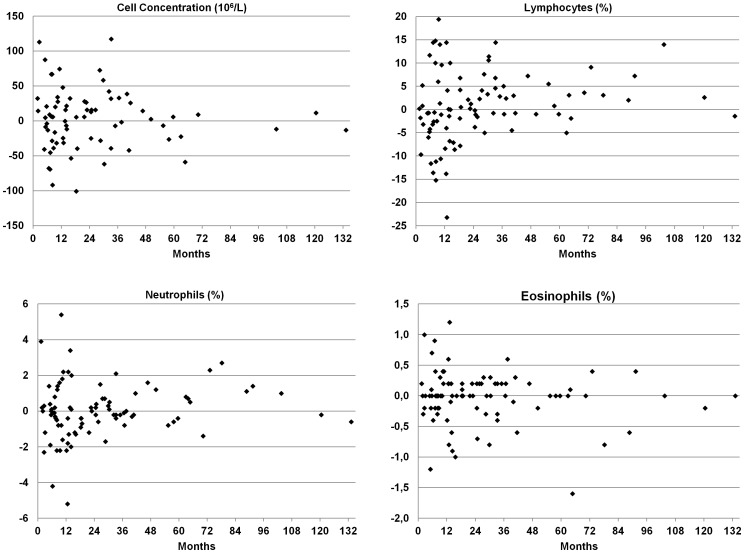
Change in bronchoalveolar lavage fluid findings from first BAL (y-axis) related to time between investigations (x-axis) in healthy never-smoking subjects.